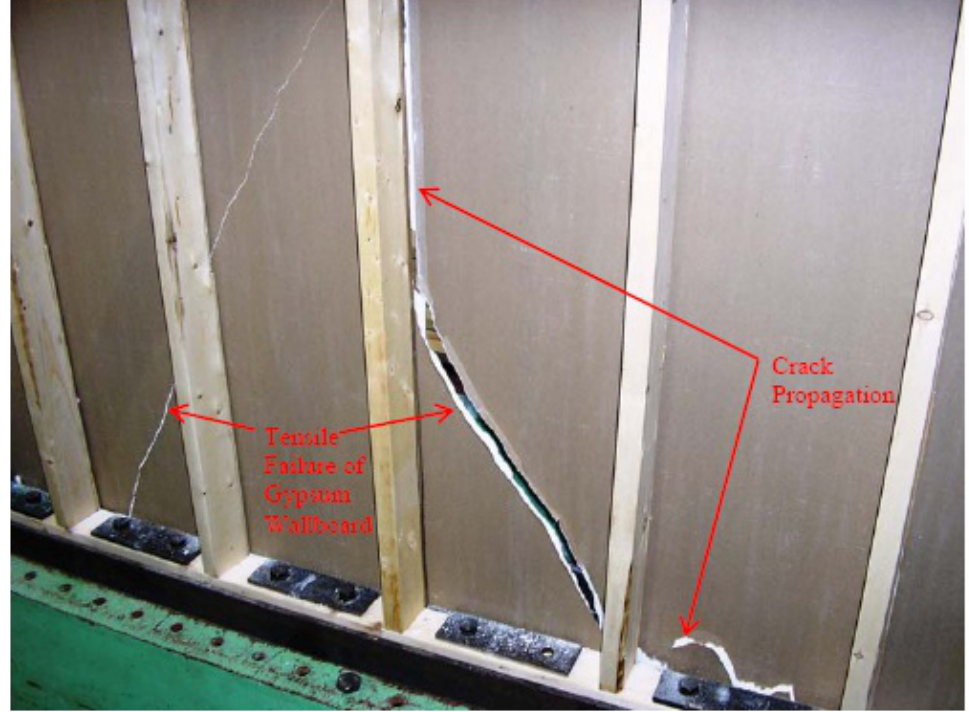
Figure 21. Damage to lower half of VEwall 1.